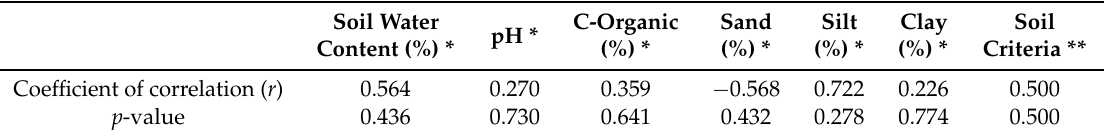
Table 3. Correlation between soil characteristics at a depth of 0–20 cm below the soil surface and percentage of termite